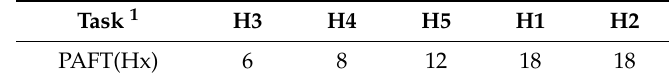
Table 17. PPA table for tasks in Hilbert transforms.